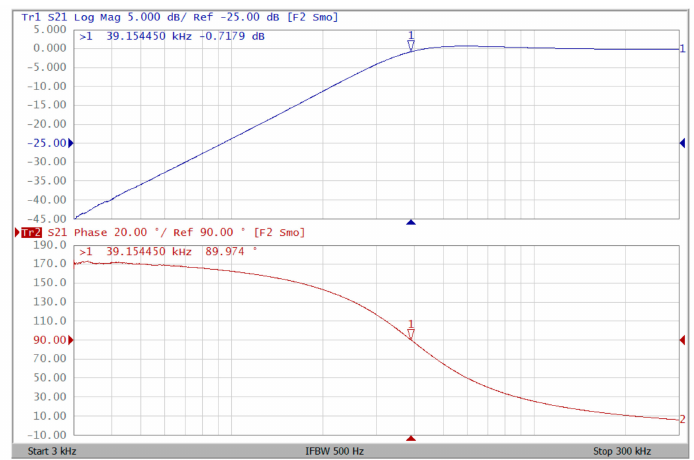
Figure 21. Measured gain and phase responses at V o1 when V i1 = 0 and V i2 = V in .